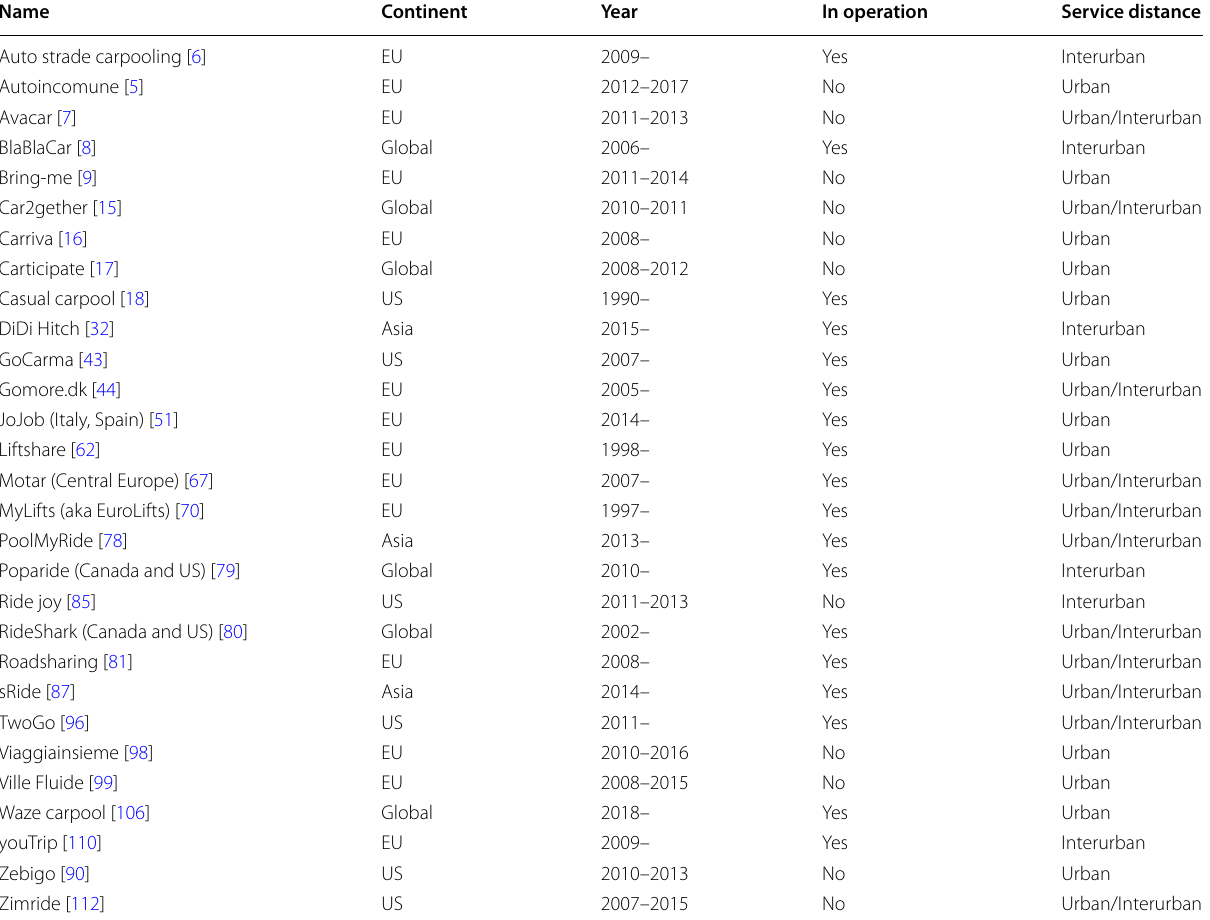
Table 3 Summary of ride-sharing